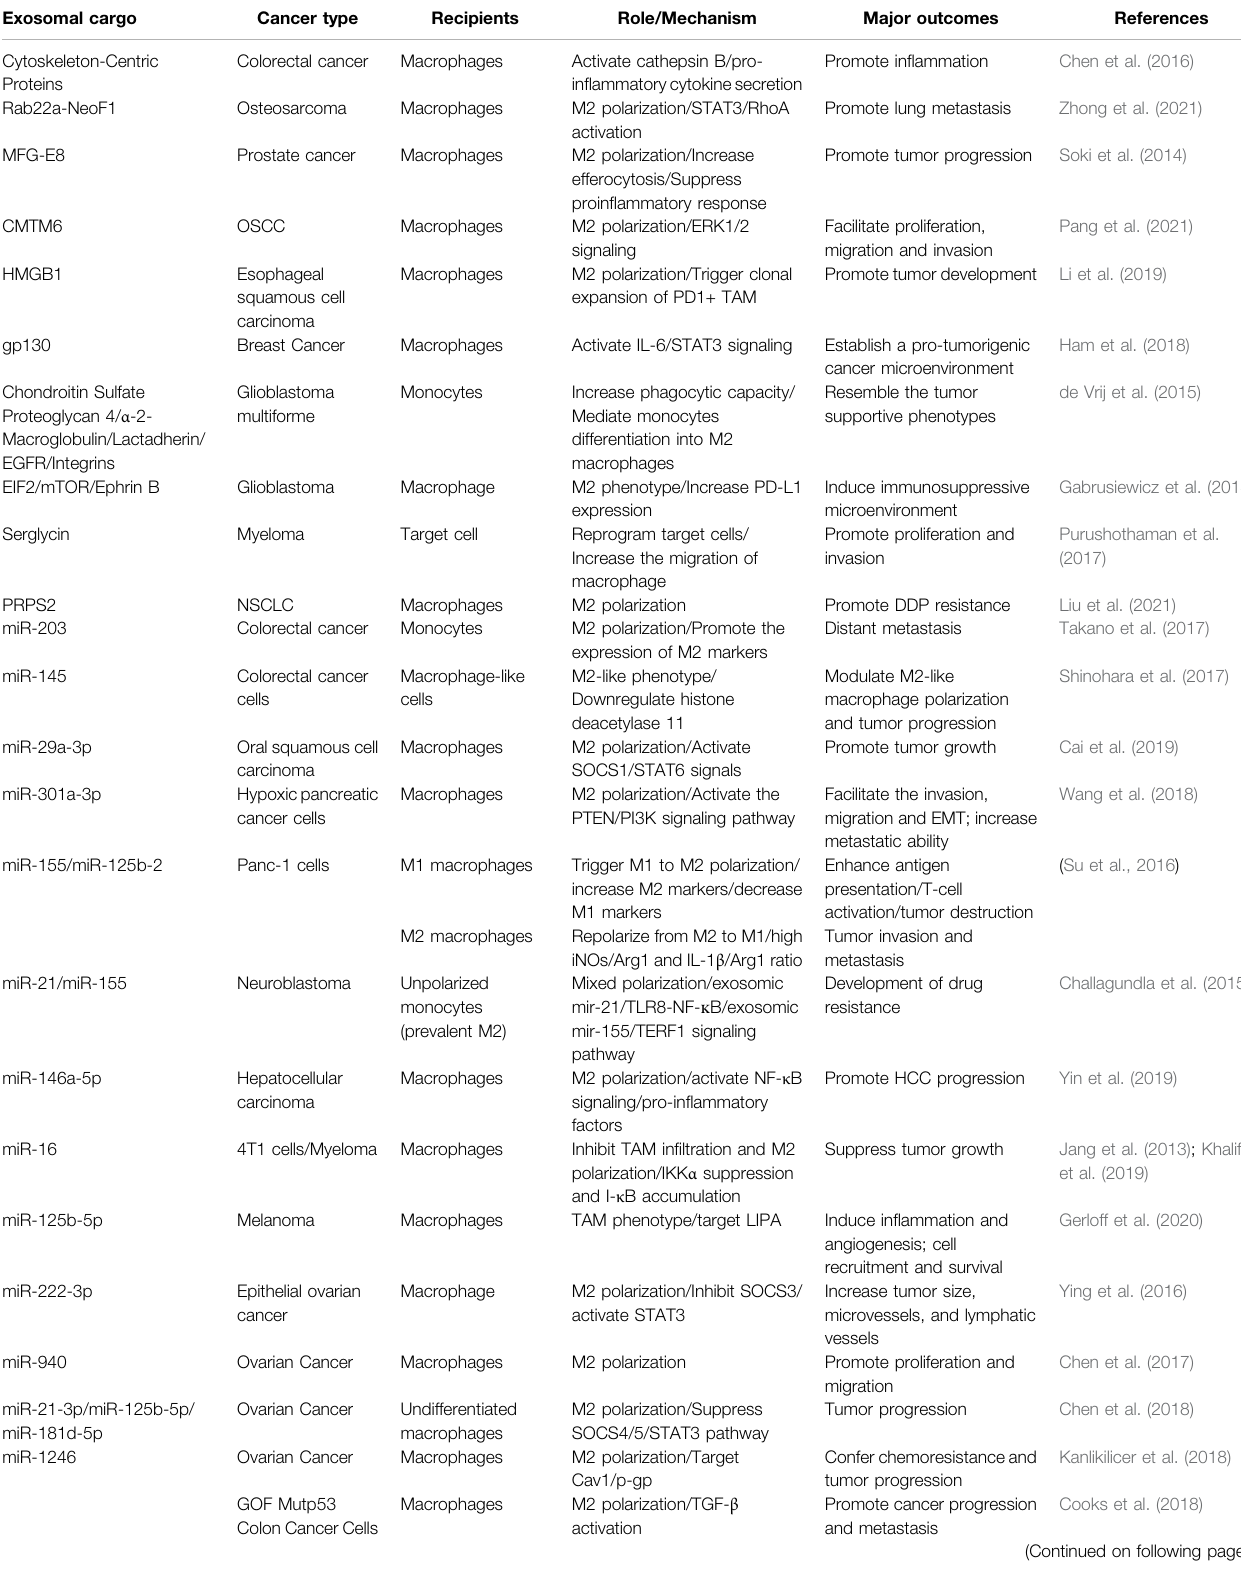
TABLE 1 | Tumor-derived exosomal cargoes stimulate polarization of